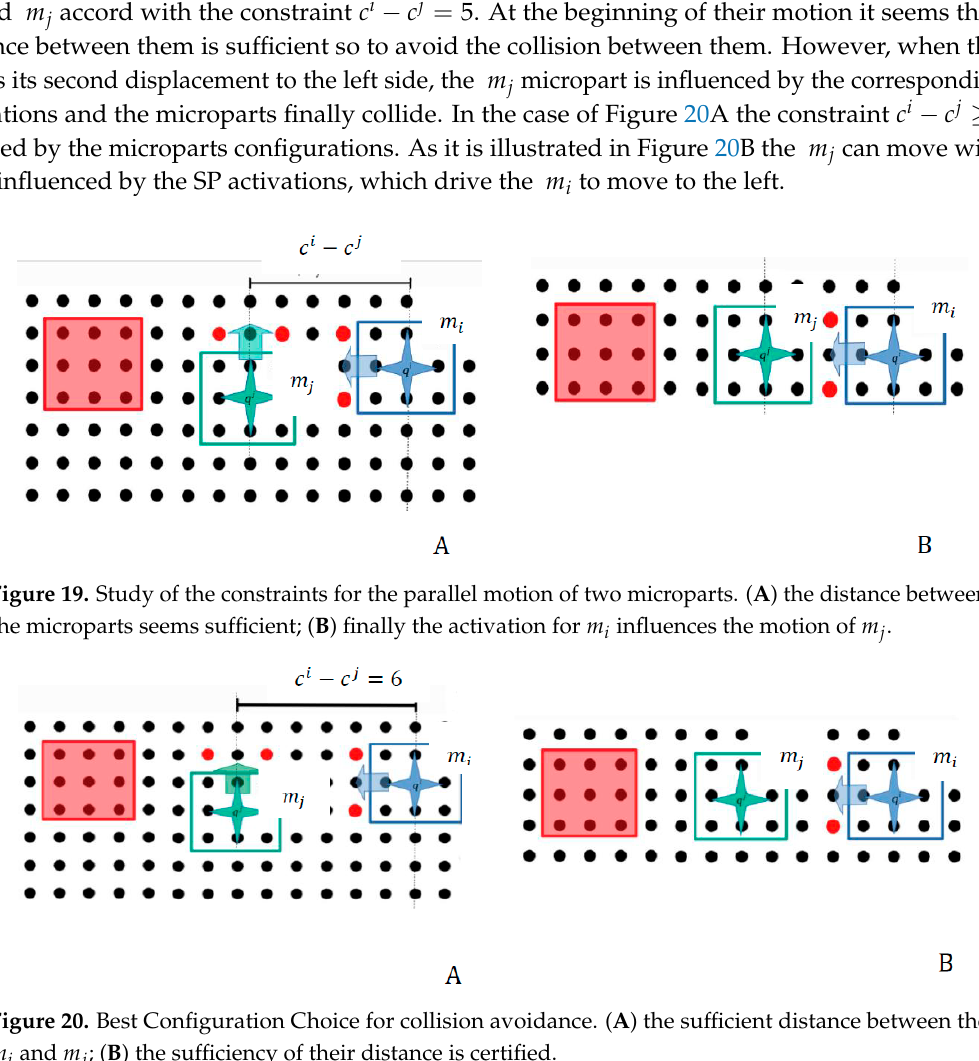
Figure 21. Constraints for the parallel motion of two microparts which diverge the one from the other. Τ hus, at every time step from (cid:1872) (cid:2868) + ((cid:1871) − 1)Δ(cid:1872) to (cid:1872) (cid:2868) + (cid:1871)Δ(cid:1872) the (cid:1850) (cid:3042)(cid:3029)(cid:3046) (cid:3036)(cid:3037) is determined considering the constraints of Table 3. Thus, the resulting (cid:1850) (cid:3042)(cid:3029)(cid:3046) space is described by: